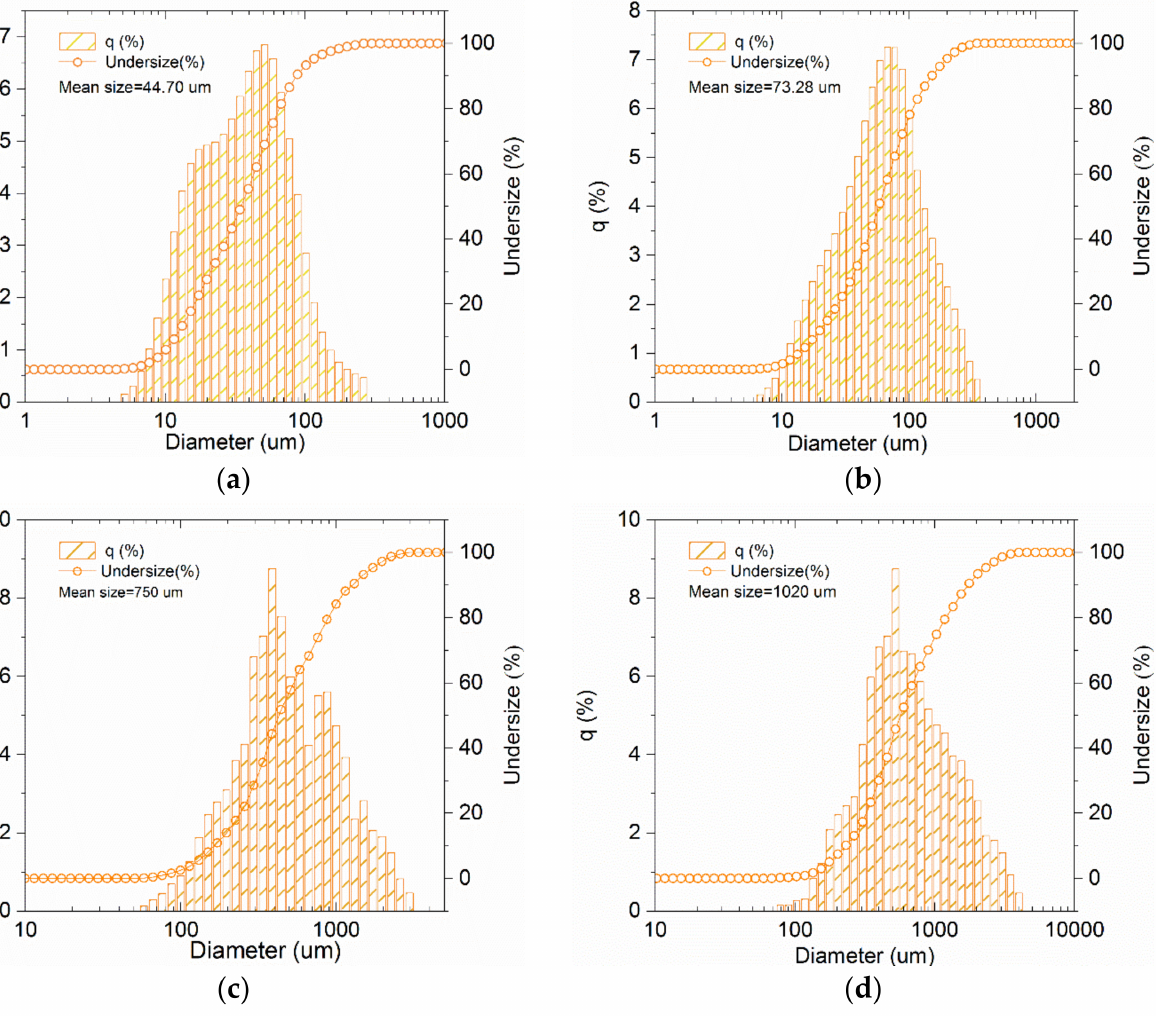
Figure 2. The fineness distribution of BC; ( a ) BC-1, ( b ) BC-2, ( c ) BC-3, and ( d ) BC-4. Table 2. The material mix ratios of the mortar specimens